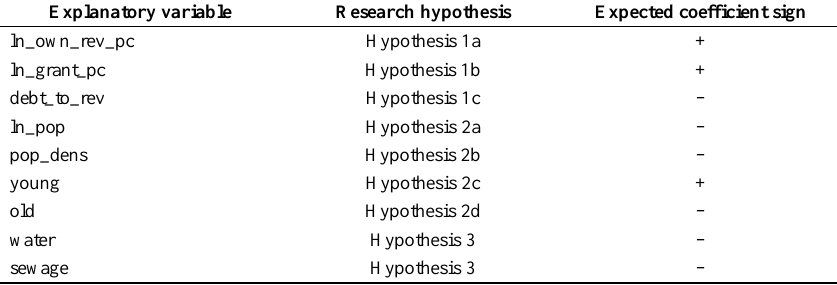
Table 2. Nexus between explanatory variables and research